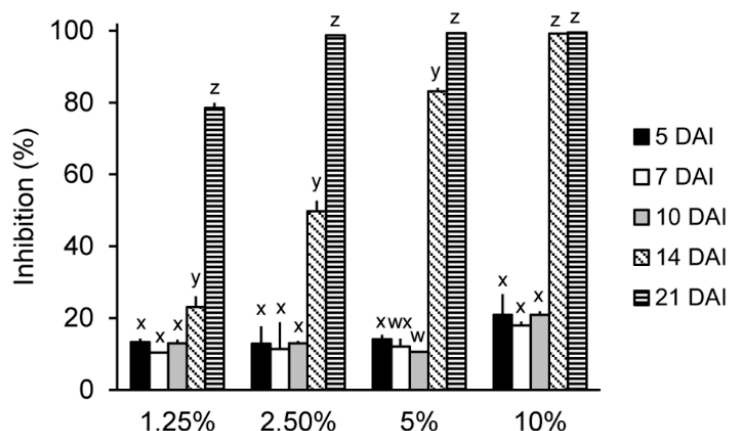
Figure 2. Effects of the incubation time of the IUM00035 isolate on the antifungal activity of its culture filtrate. The IUM00035 culture filtrate was added to wells containing Saccharomyces cerevisiae to reach final concentrations of 1.25%, 2.50%, 5%, and 10% ( v/v ). The different small letters in each bar indicate a significant difference at P < 0.05 (Duncan’s test).